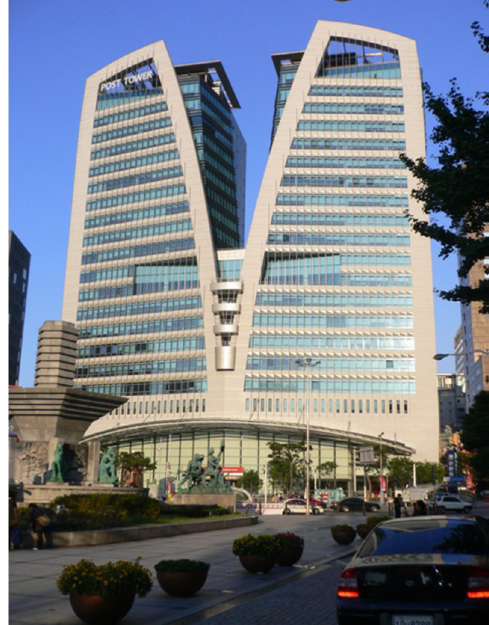
Figure 2. The main façade of the office building.